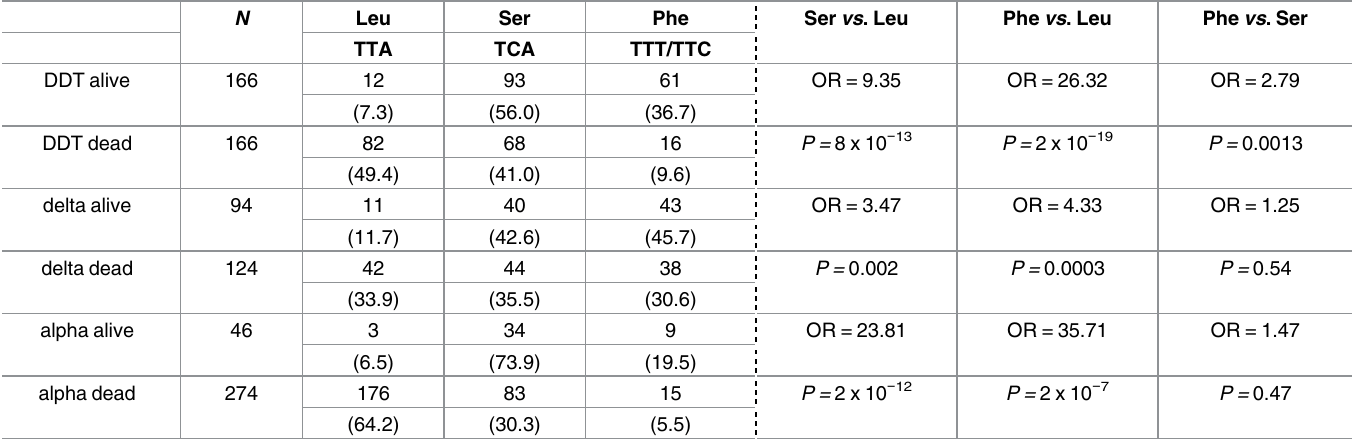
Table 1. Allele frequencies at Vgsc -1014and their relationship with insecticide susceptibility.